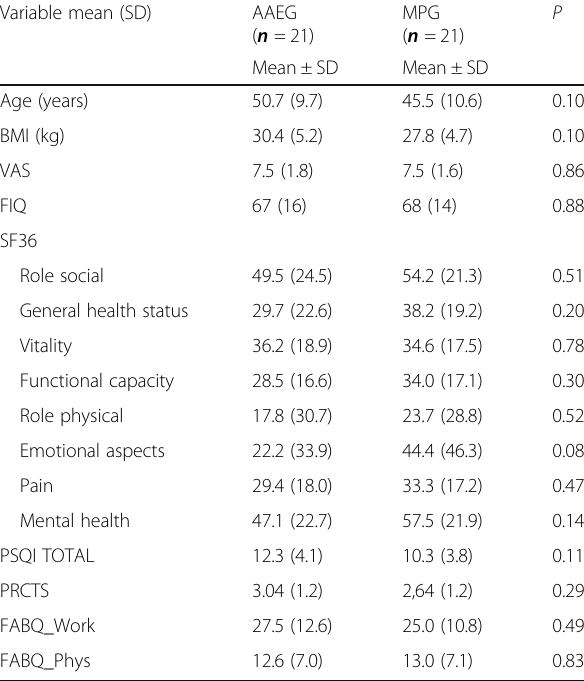
Table 1 Mean, standard deviation (SD) values of all analyzed variables of the two groups of patients with fibromyalgia at